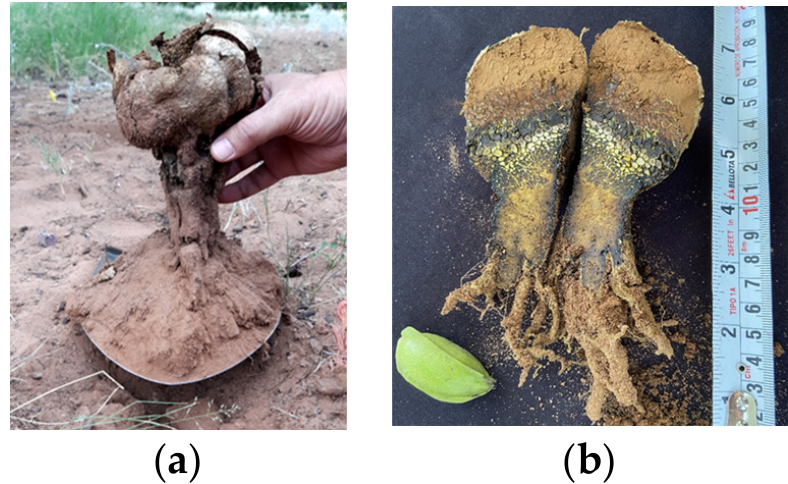
Figure 6. Fruiting bodies formed in the La Concha pecan orchard. ( a ) Pisolithus arenarius accession number OM780027 (2020) ( b ) Pisolithus tinctorius accession number OM780028 (2021); both are from the NCBI.